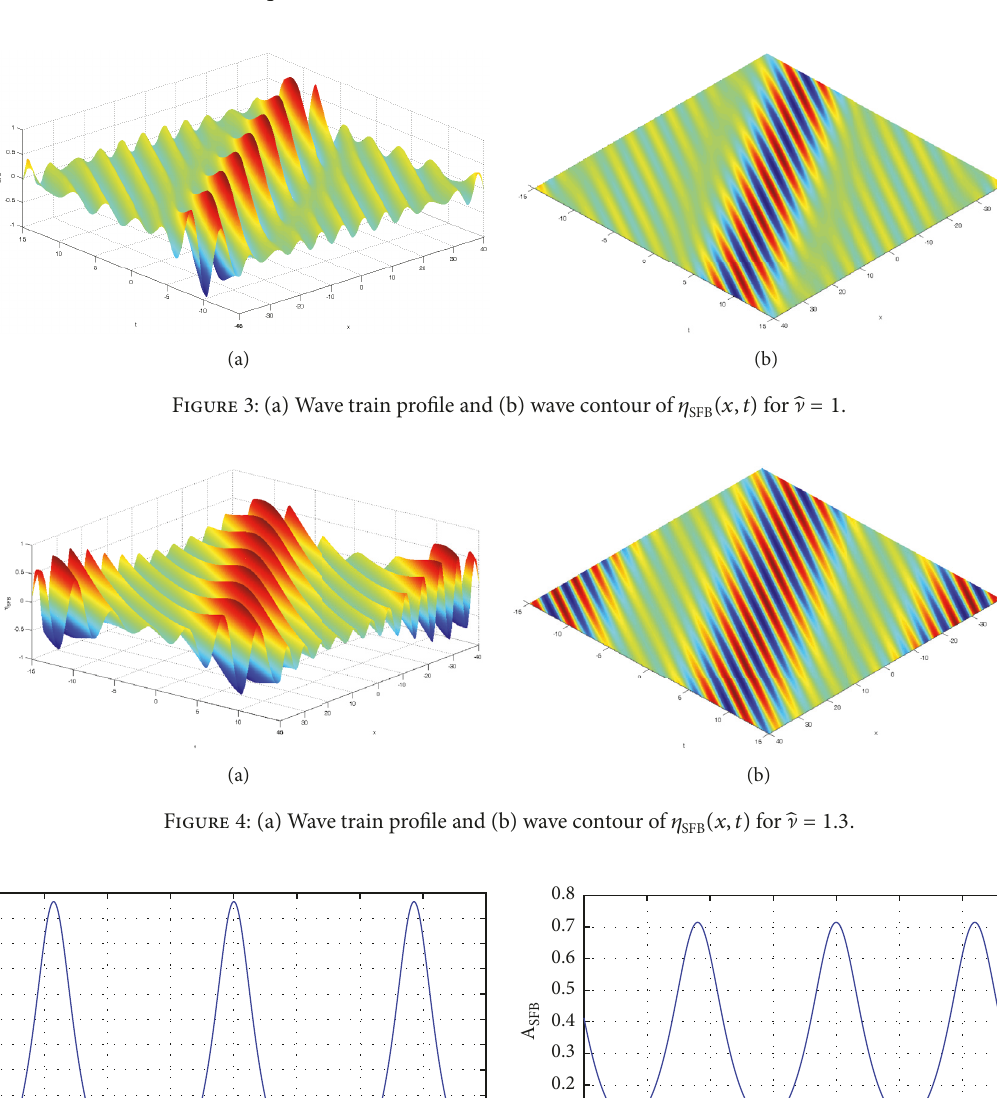
(𝑥,𝑡)| at 𝑥 = 0 for ̂ ] = 1.3 . SFB